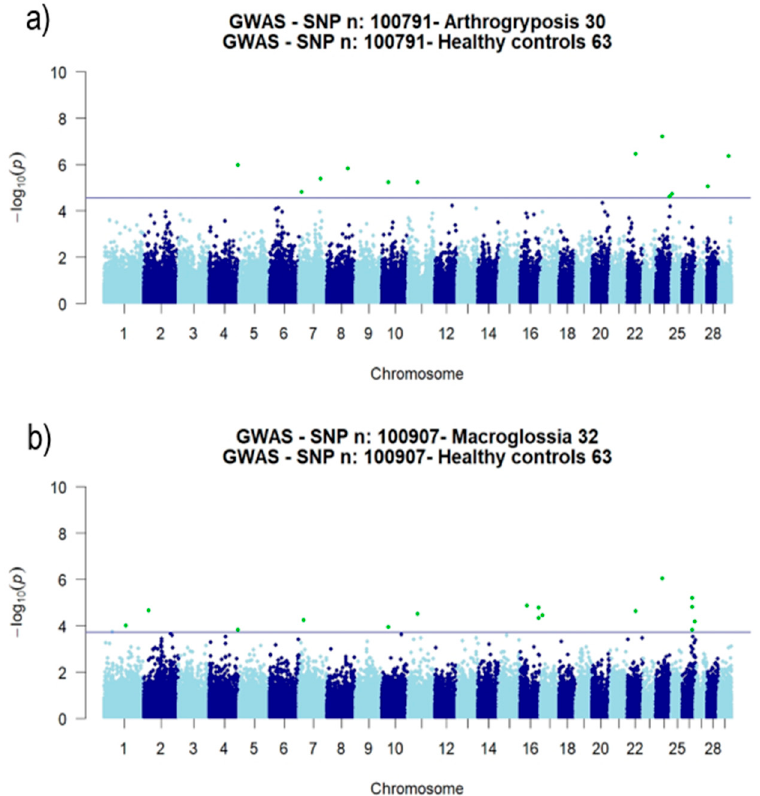
Figure 1. Manhattan plots. ( a ) Healthy vs. arthrogryposis and ( b ) healthy vs. macroglossia. GWAS: genome-wide association study and SNP: single nucleotide polymorphism.